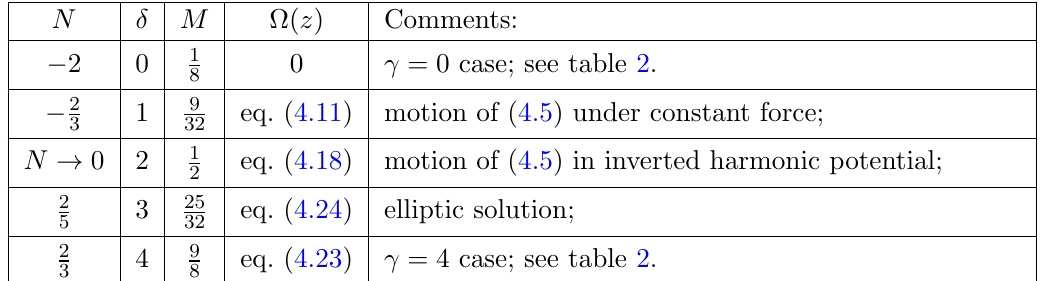
Table 2 . Summary of solutions for the mechanical system (4.3) expressed in terms of elliptic functions (and their degeneracies).